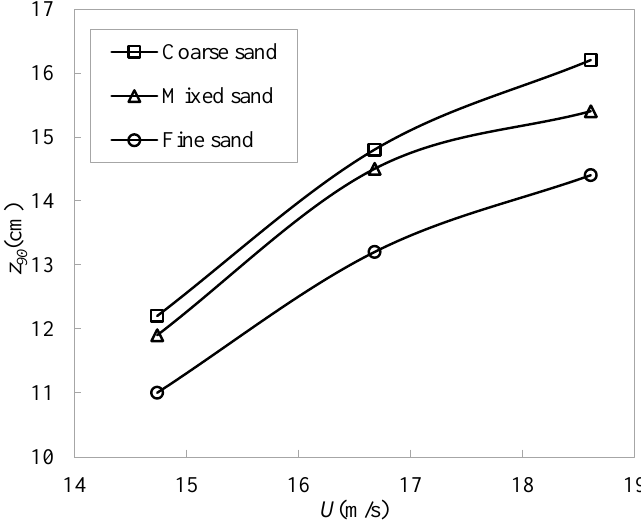
Figure 8. The relationship between Z 90 and wind speed.